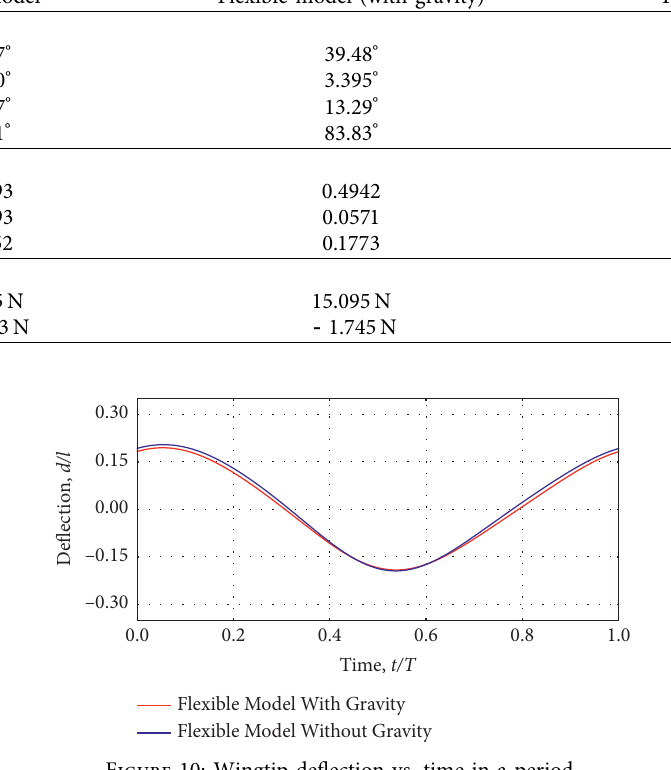
Figure 10: Wingtip deflection vs. time in a period.